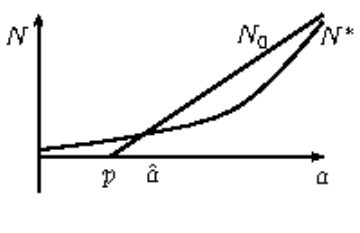
Fig. 4 Sketch of the transcritical bifurcations undergone by the system’s